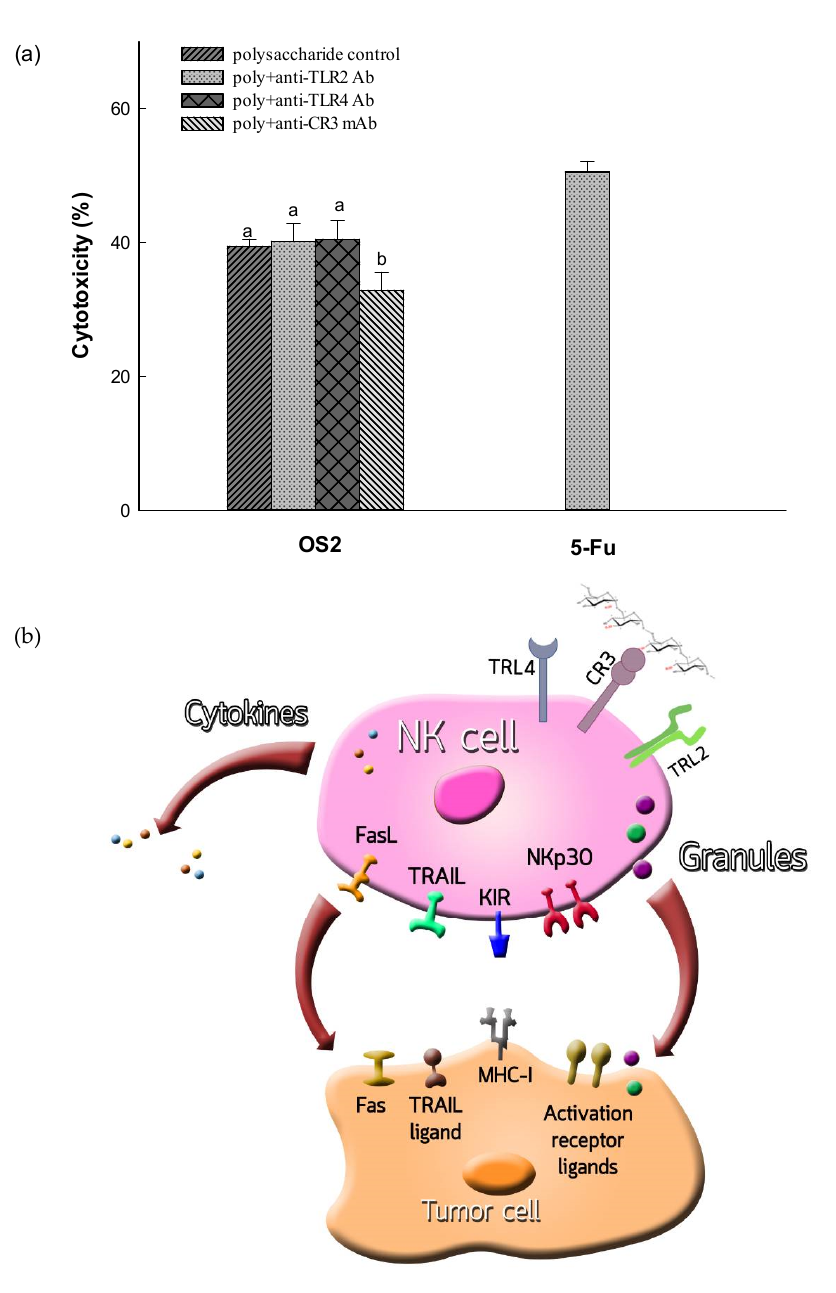
Figure 8. Effect of OS2 cytotoxicity against HepG2 cells in antibody neutralization: ( a ) cytotoxicity against HepG2 cells and, ( b ) a schematic illustration for the interaction of OS2 with CR3. Different letters indicate significant differences ( p < 0.05) between polysaccharide control (OS2), and OS2 + anti-TLR2 Ab, OS2 + anti-TLR4 Ab, and OS2 + anti-CR3 Ab.